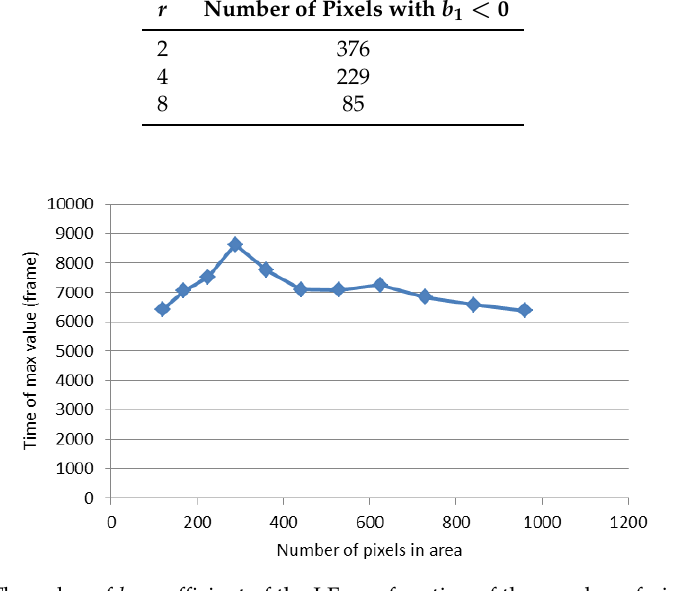
Figure 11. The value of b 1 coefficient of the LF as a function of the number of pixels in ROI.